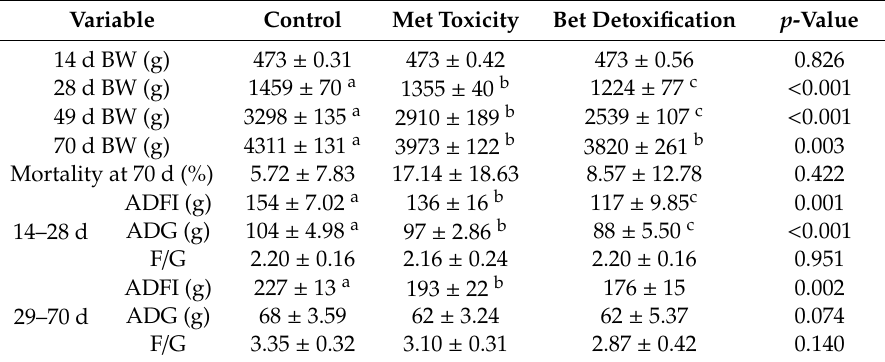
Table 2. E ff ect of betaine on the growth performance of geese with hyperhomocysteinemia. Variable